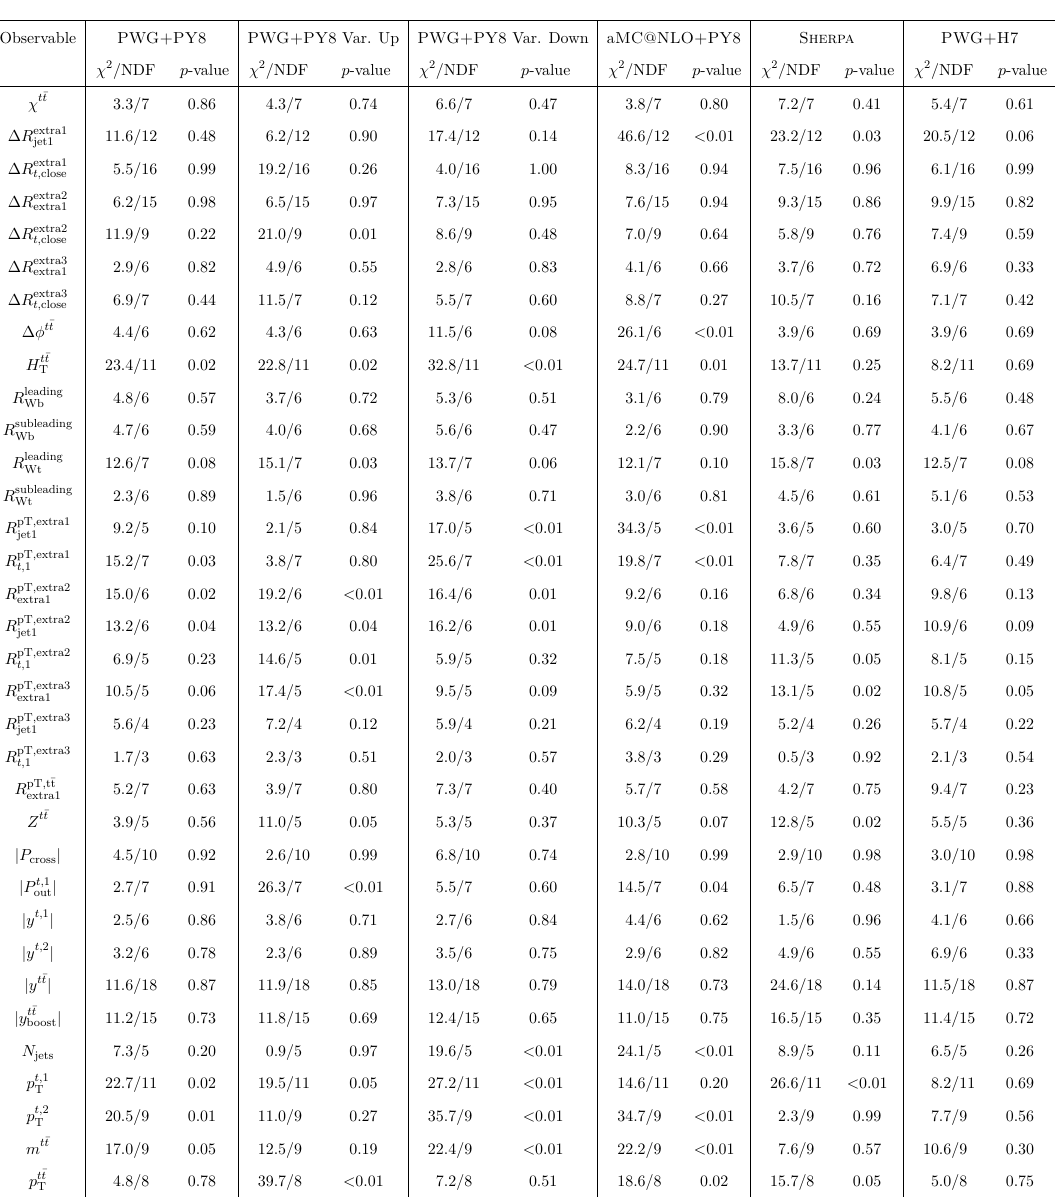
Table 8 . Comparison of the measured particle-level absolute single-differential cross-sections with the predictions from several MC generators. For each prediction, a χ 2 and a p -value are calculated using the covariance matrix of the measured spectrum. The number of degrees of freedom (NDF) is equal to the number of bins in the